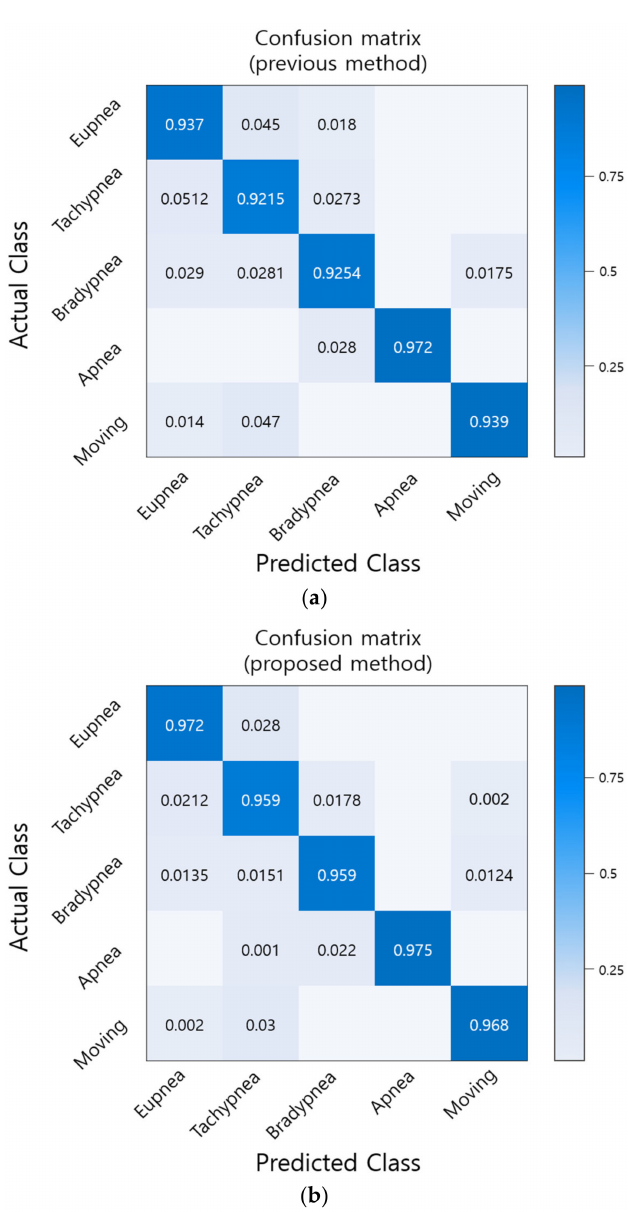
Figure 8. Comparison of recognition rate by respiration pattern for existing and proposed methods. ( a ) Recognition rate of existing method [28]; ( b ) Recognition rate of proposed